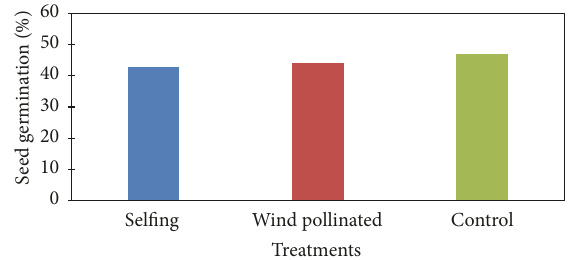
Figure 4: Seed germination percentage for the three